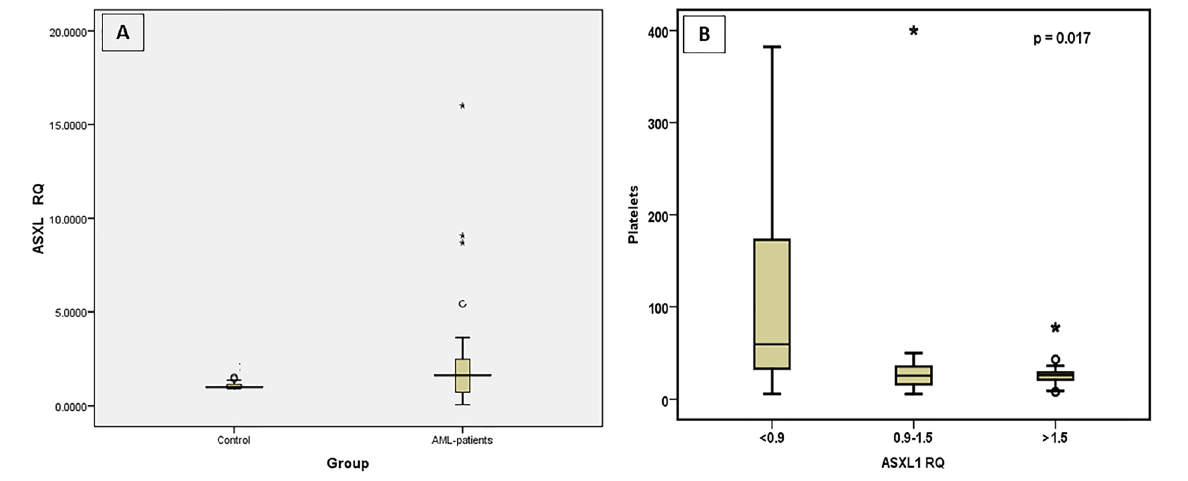
Figure 1 - Significance of ASXL1 expression. ASXL1 expression levels, represented as RQ value, in AML patients and in Control groups (A). Correlation between platelets numbers and ASXL1 expression levels